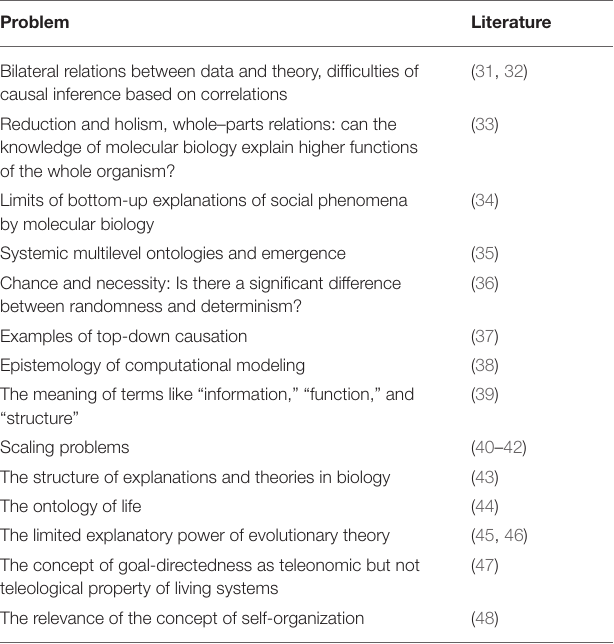
TABLE 1 | Epistemological desiderata of systems thinking in biology. Problem